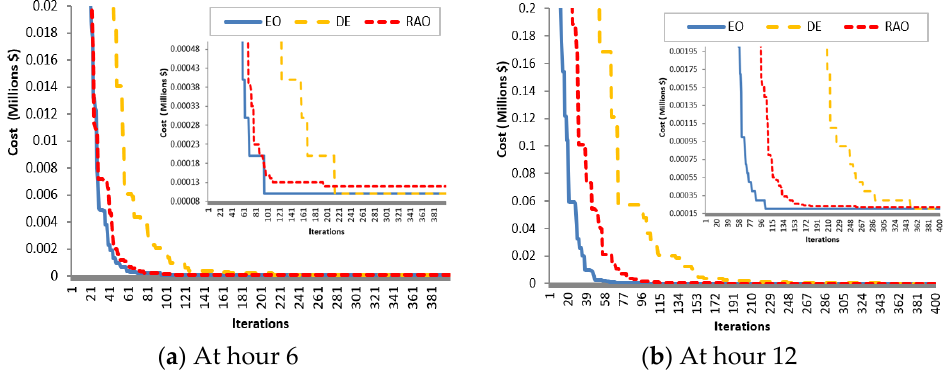
Figure 10. Convergence curves of EO, DE and RAO for the first MG at hours 6 and 12, respectively. Table 2. Optimal operations of MG at hour 6 using EO, DE, and RAO algorithms. EO DE